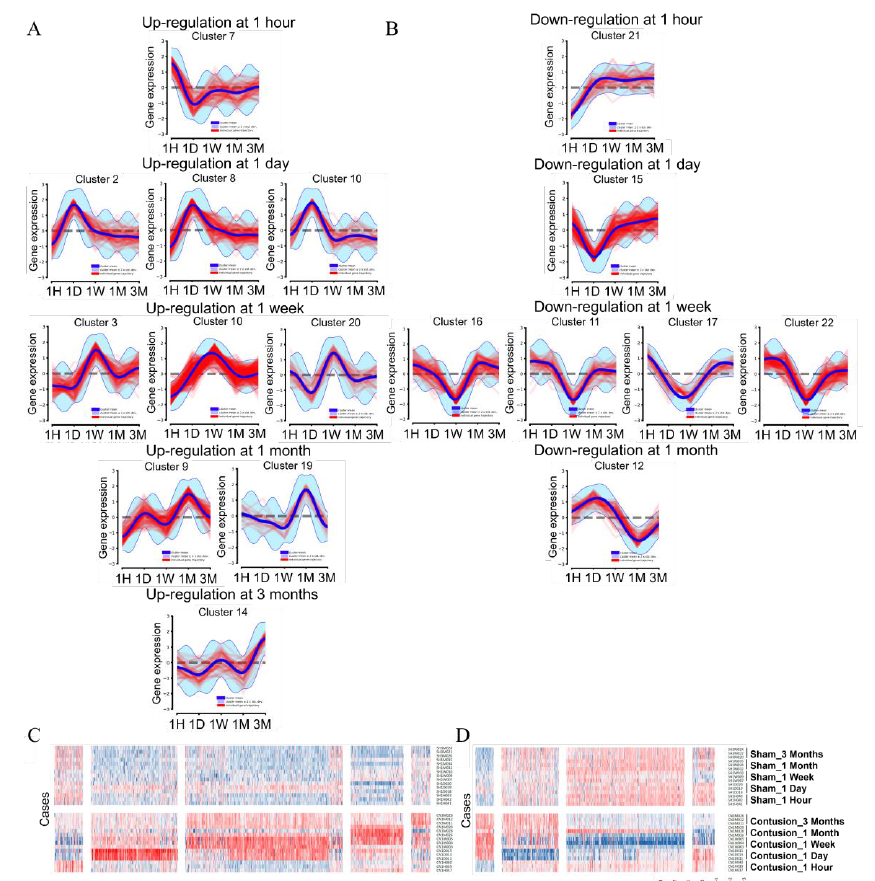
Figure 3. Clustered trajectories of genes in response to SCI. ( A , B ) Up- ( A ) and downregulation ( B ) patterns of time period-specific expression trajectories. For each cluster in ( A , B ), standardized log2-fold change waves (red lines) in expression at five time points are shown for individual gene trajectories, and the sky-blue boundaries indicate the posterior cluster mean ± 2 standard deviations according to the cluster-specific GP. ( C , D ) The heatmap results with actual expression levels of each module isolated through Dirichlet process Gaussian process mixture model (DPGP) clustering of up- ( C ) and downregulated ( D ) cases of contusion models compared to sham controls. Abbreviation: 1H = 1 hour, 1D = 1 day, 1W = 1 week, 1M = 1 month, 3M = 3 months.